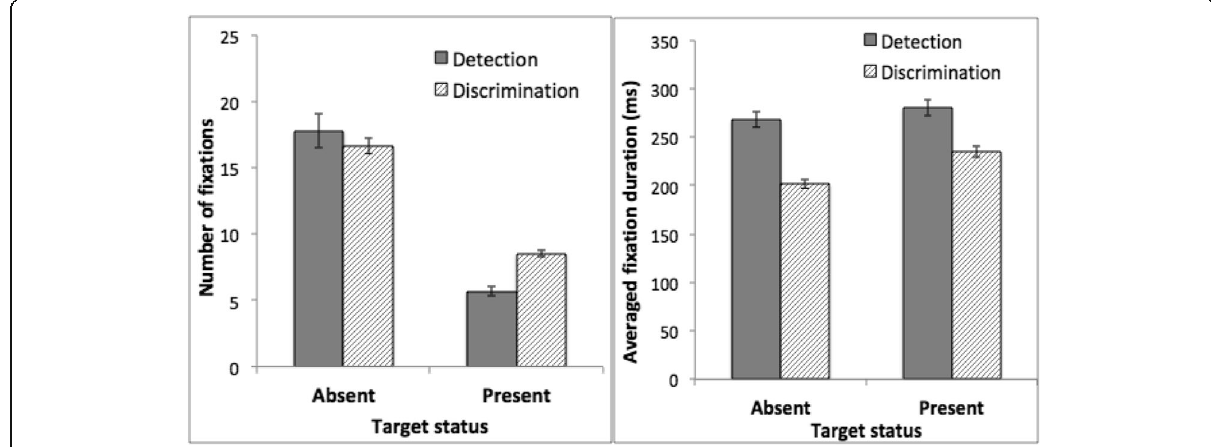
Fig. 5 Fixation data from the testing phase of Experiment 2. Left : Average number of fixations per trial. Right : Mean fixation duration. Error bars show ±1 S.E. of the mean